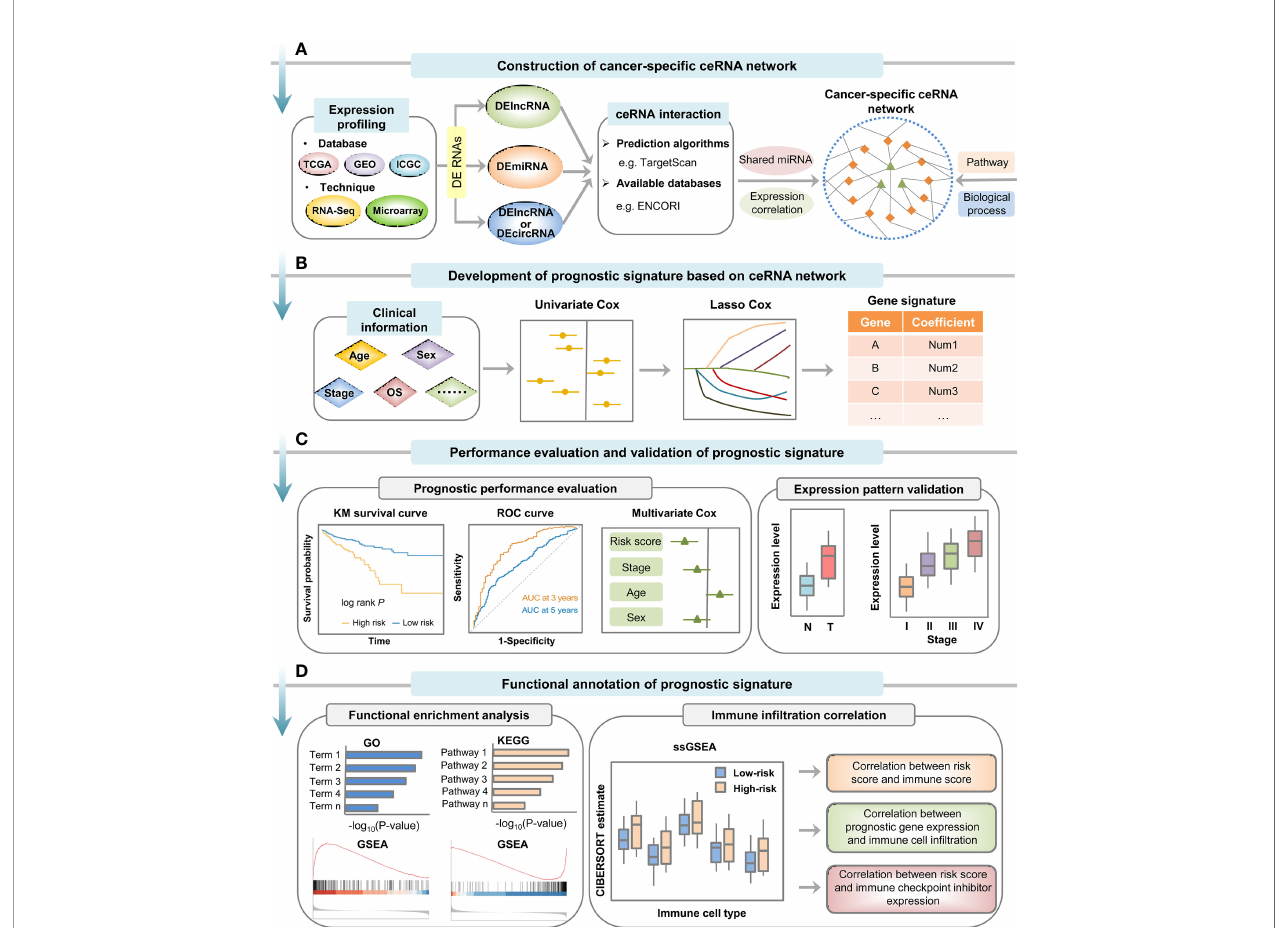
FIGURE 2 | Computational strategy for construction, validation and functional annotation of ceRNA network-based prognostic signature in cancer. (A) Cancer-speci fi c ceRNA network was constructed based on expression and interaction information. (B) Prognostic signature was developed by employing univariate Cox regression analysis and LASSO Cox regression analysis. (C) Prognostic performance of the signature should be evaluated and validated by Kaplan-Meier survival curve analysis, time-dependent ROC curve analysis and multivariate Cox regression analysis, and the expression pattern of genes that make up the model can be veri fi ed in other independent datasets. (D) Biological role of the prognostic signature could be investigated by functional enrichment analysis and immune in fi ltration